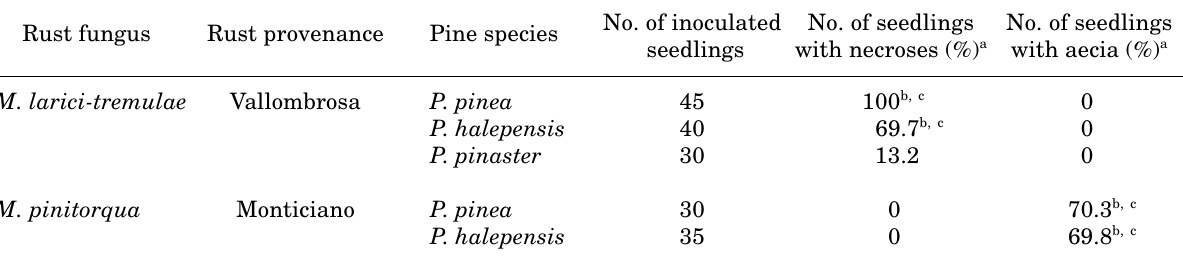
Table 1. Cortical necroses and aecia on shoots of Pinus pinea, P. halepensis and P. pinaster seedlings inoculated with Melampsora larici-tremulae from Vallombrosa and M. pinitorqua from Monticiano. No. of inoculated No. of seedlings No. of seedlings Rust fungus Rust provenance Pine species seedlings with necroses (%) a with aecia (%)